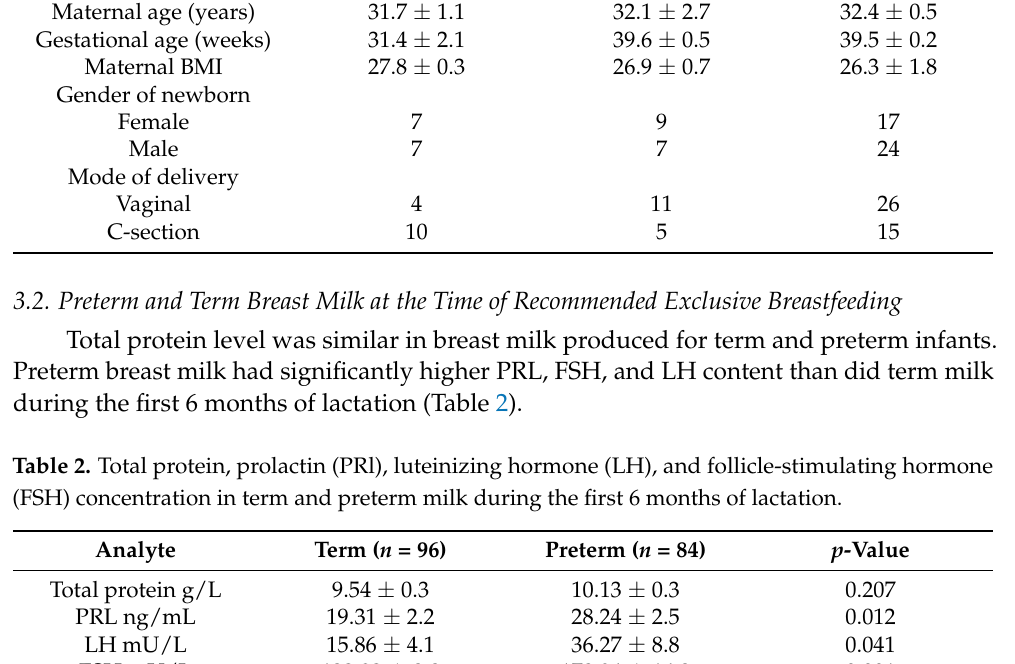
Preterm Maternal